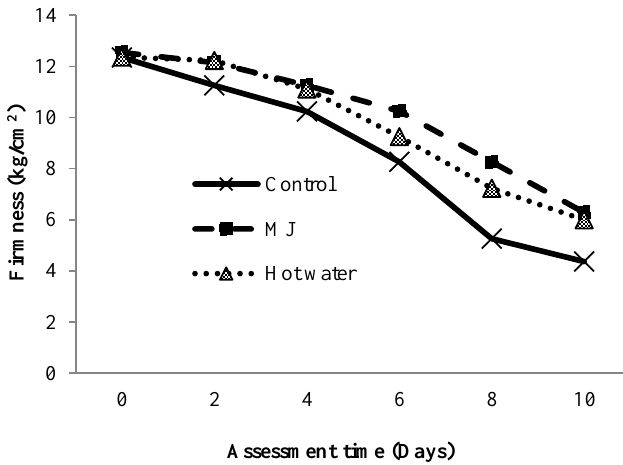
Figure 2. Effects of different postharvest treatments on firmness of apricot fruits during storage at room temperature (MJ: methyl jasmonic acid).